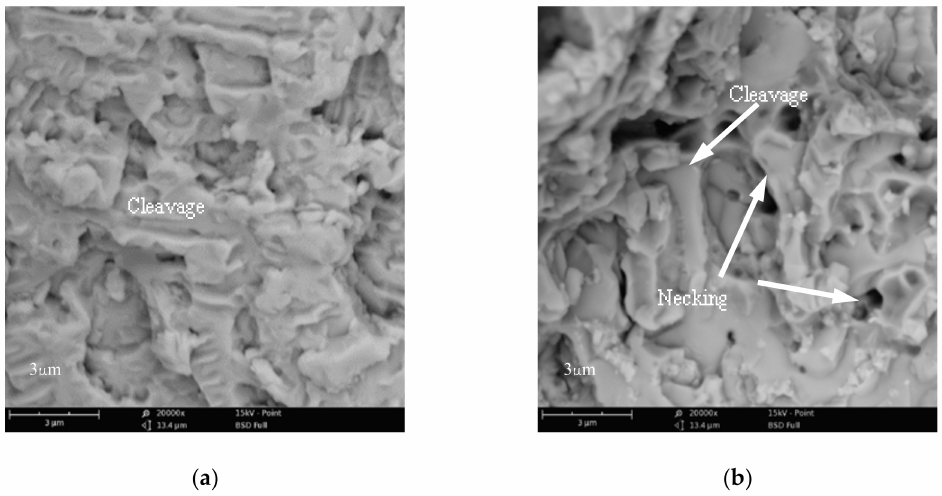
Figure 10. SEM observation of the fracture surfaces of WC/Fe composite coatings ( a ) without Co and ( b ) with 8% Co.